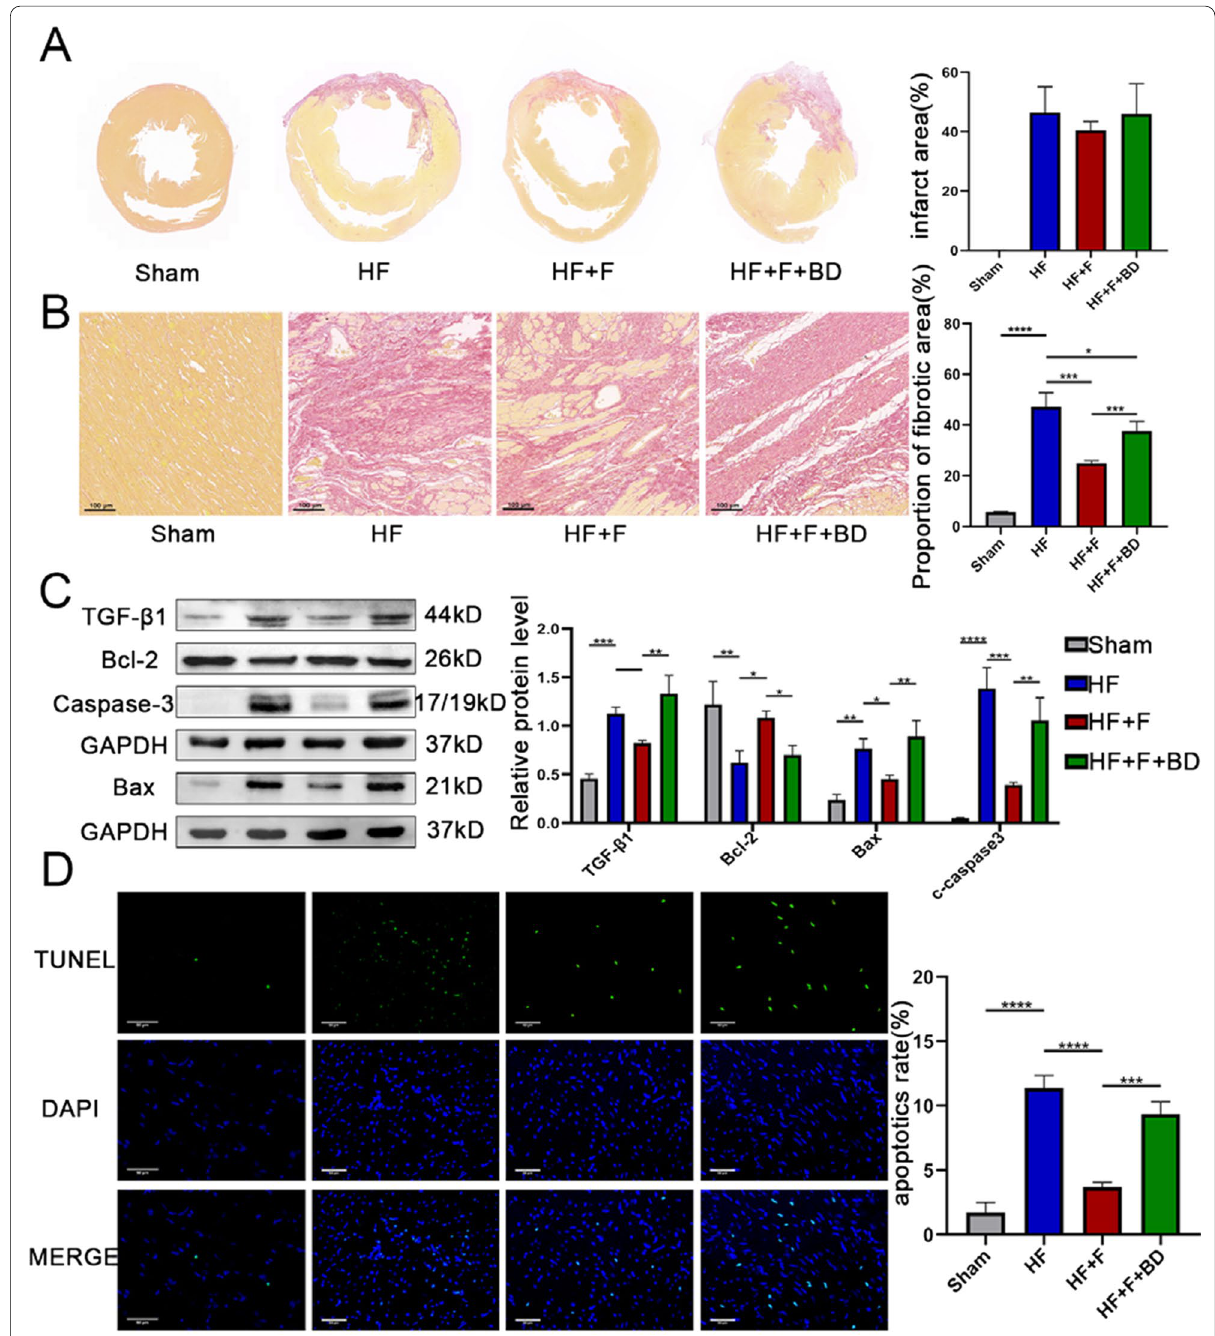
Fig. 3 Stimulation of sigma-1 receptor alleviated post-infarct heart failure-induced ventricular remodeling. A S1R stimulation reduced infarct area; B S1R stimulation decreased collagen deposition in the peri-infarction zone, evidenced by the Sirius red dyeing; C Western blot results showed that stimulation of S1R improved apoptosis and fibrosis. N 3 for quantified analysis; D S1R stimulation reduced cardiomyocyte apoptosis in the = peri-infarct region, which was detected by Terminal-deoxynucleotidyl Transferase-Mediated Nick-End Labeling (TUNEL) assay. *P < 0.05; **P < 0.01; ***P < 0.005; ****P <